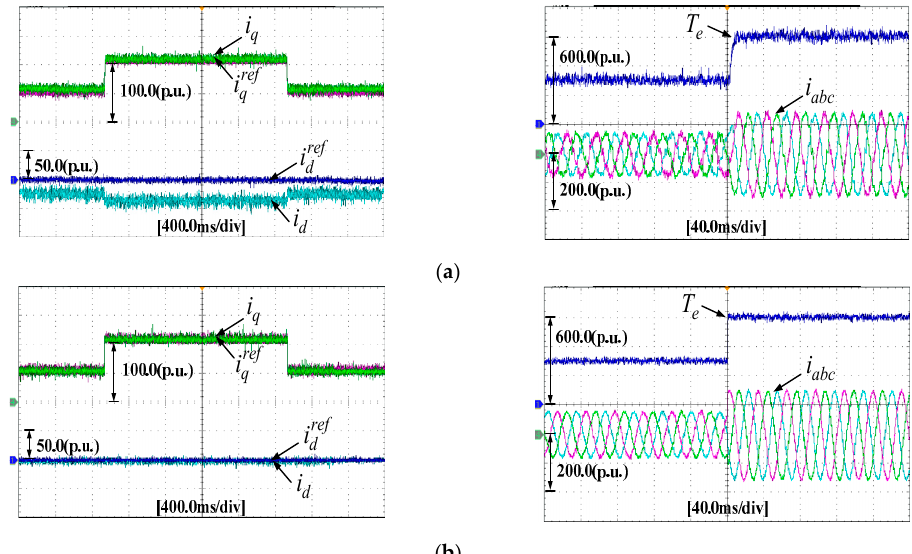
Figure 13. Experimental comparison of the two controllers against step change of the flux linkage: ( a ) Conventional PI and ( b ) proposed CRFTPC.